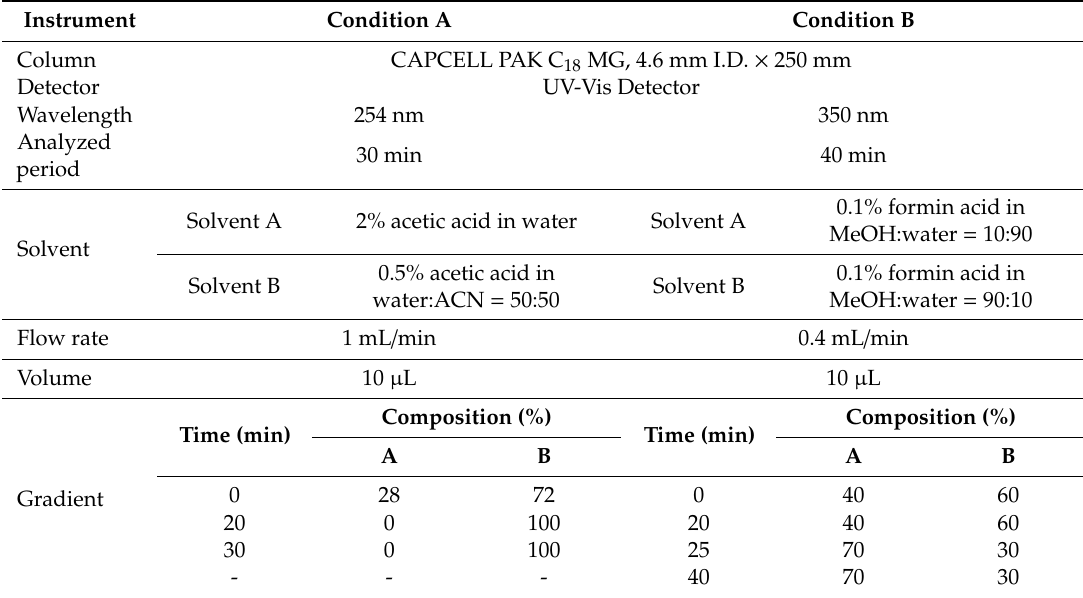
Table 2. Instrument and working conditions for high-performance liquid chromatography (HPLC) of quercetin, kaempherol, silibinin, and